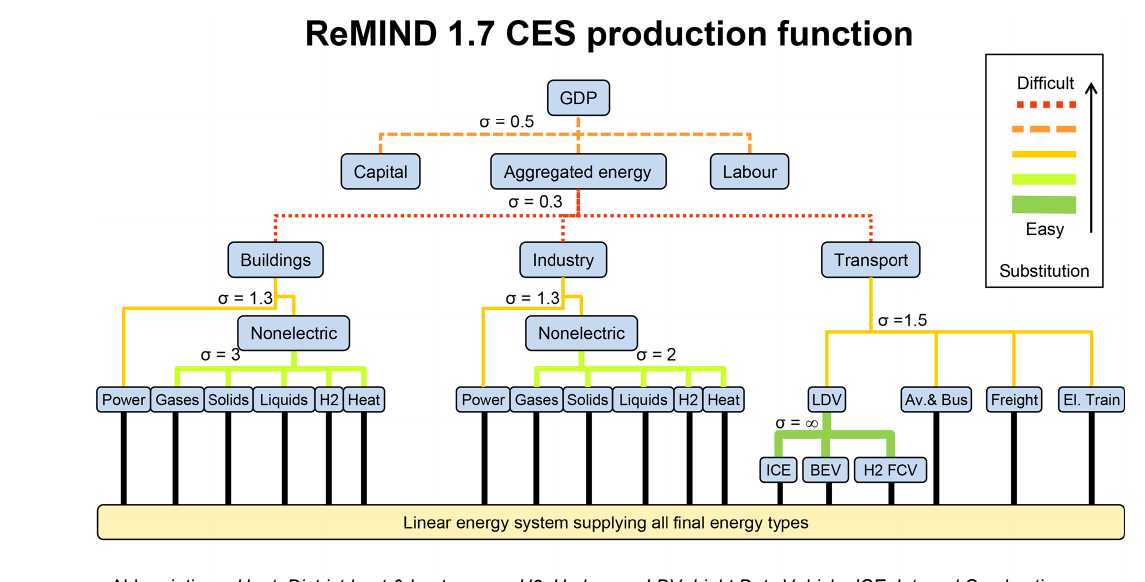
Figure A5. CES production function of the REMIND 1.7 model. Nested CES (constant elasticity of substitution) production functions determine the substitution of production factors, sector-specific energy demands, and energy carriers in the different levels of the function. The macro-economic production function is calibrated for consistency with historic trends; i.e. this specifically includes assumptions about future improvements of the productivity of input factors. Final energy in the baseline scenarios (without climate change) for different sectors is calibrated to projections from the EDGE2 (Energy Demand Generator version 2) model (Levesque et al.,